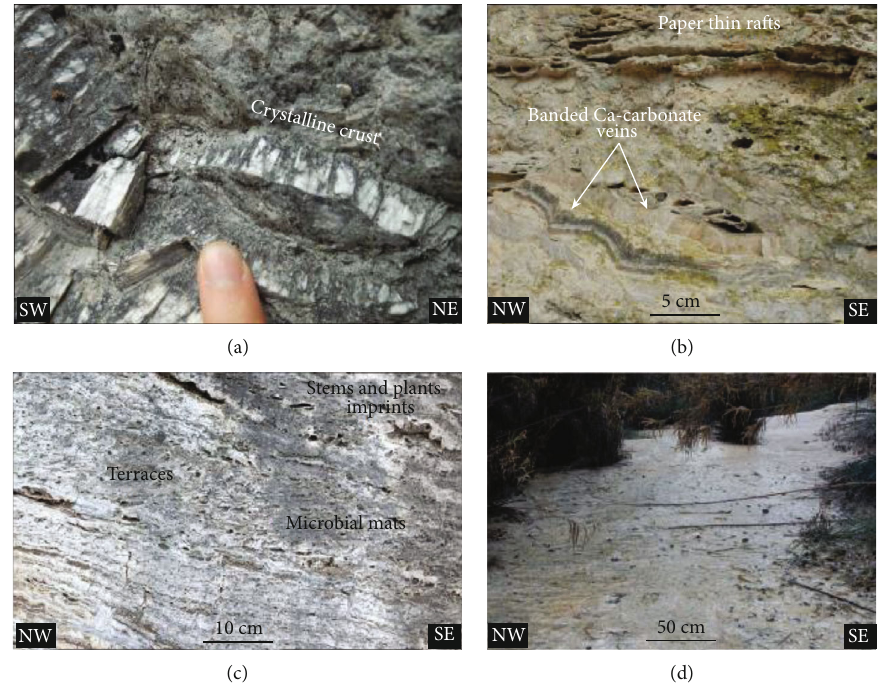
Figure 5: Main lithofacies of travertine deposits: (a) cm-thick crystalline crusts, (b) detail of paper thin raft overlying more compact travertine deposit cut by banded Ca-carbonate veins, (c) bedded travertine showing microterraces and alternation of microbial mats, with variable porosity, stem, and plants imprints, and (d) growing mound